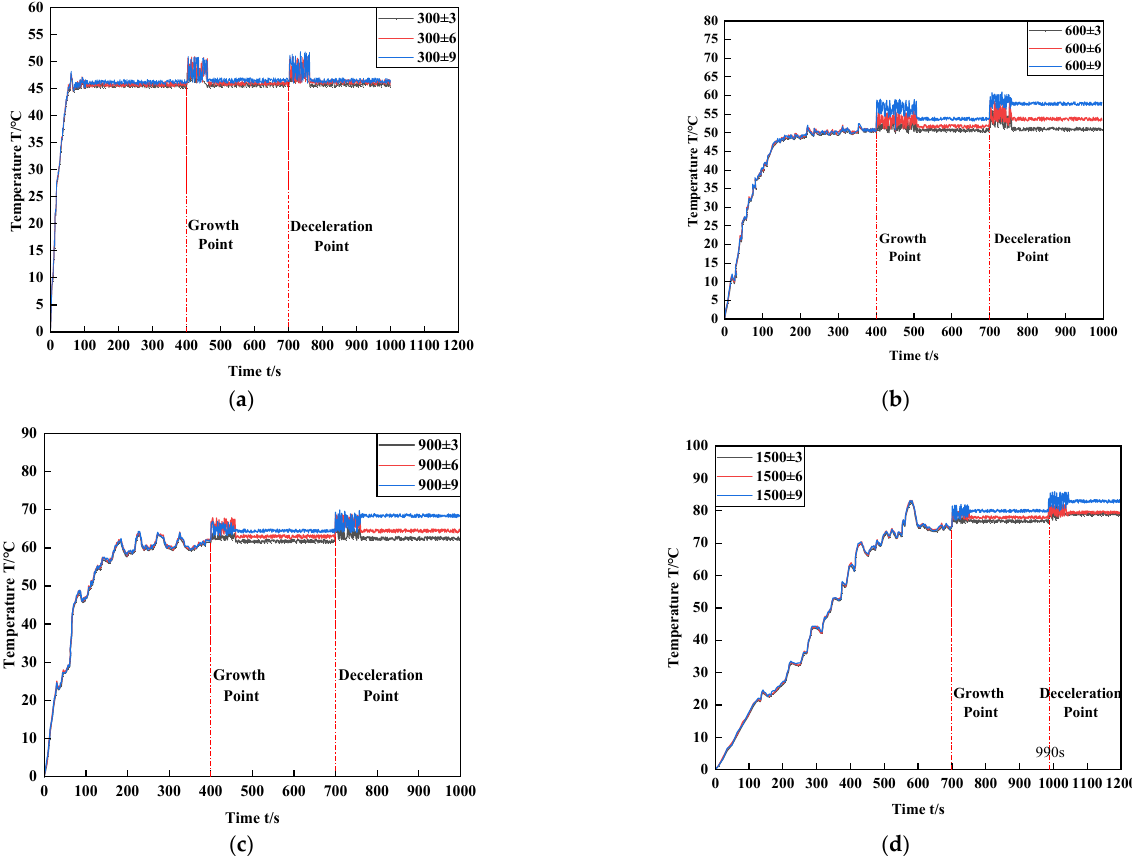
Figure 6. Temperature change in the MR fluid seal under different speed conditions: ( a ) 300 rpm; ( b ) 600 rpm; ( c ) 900 rpm; and ( d ) 1500 rpm.